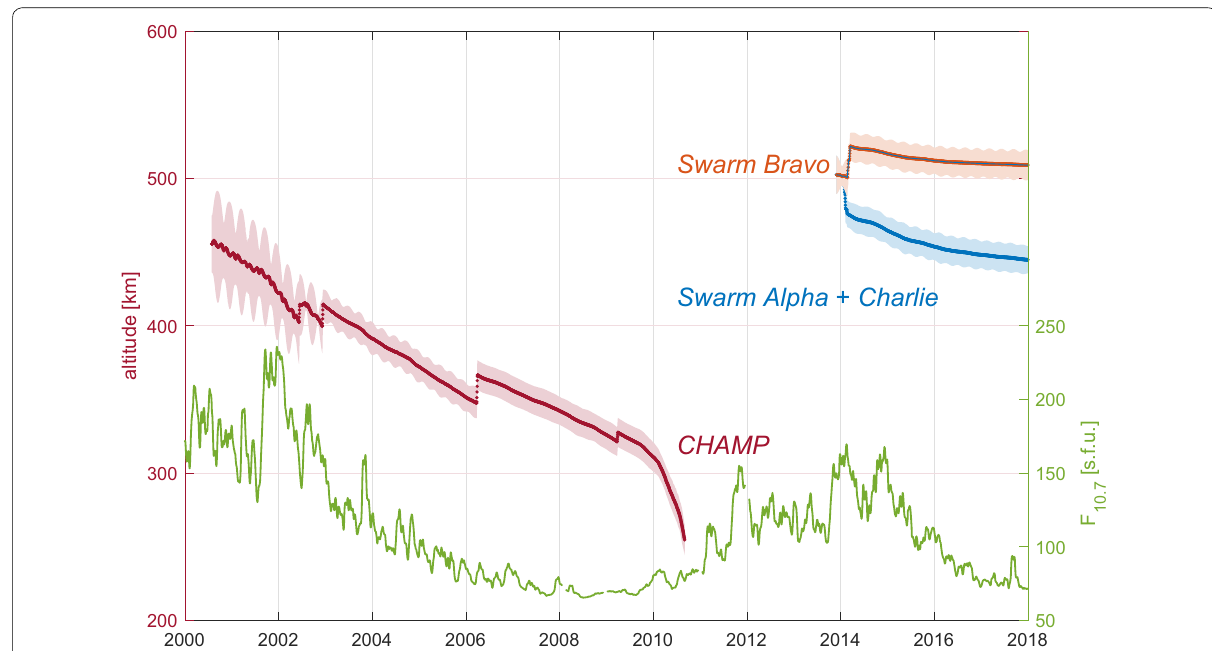
Fig. 11 Altitudes of the CHAMP (red) and the Swarm Bravo (orange), Alpha , and Charlie (blue) satellites, as indicated by the left scale, and the F 10.7 solar radiation index (green), as indicated by the right scale, from 2000 to the end of the CIY4 data envelope. The solid dark lines show the daily mean altitude, while the shaded areas indicate the range (difference between daily max and daily